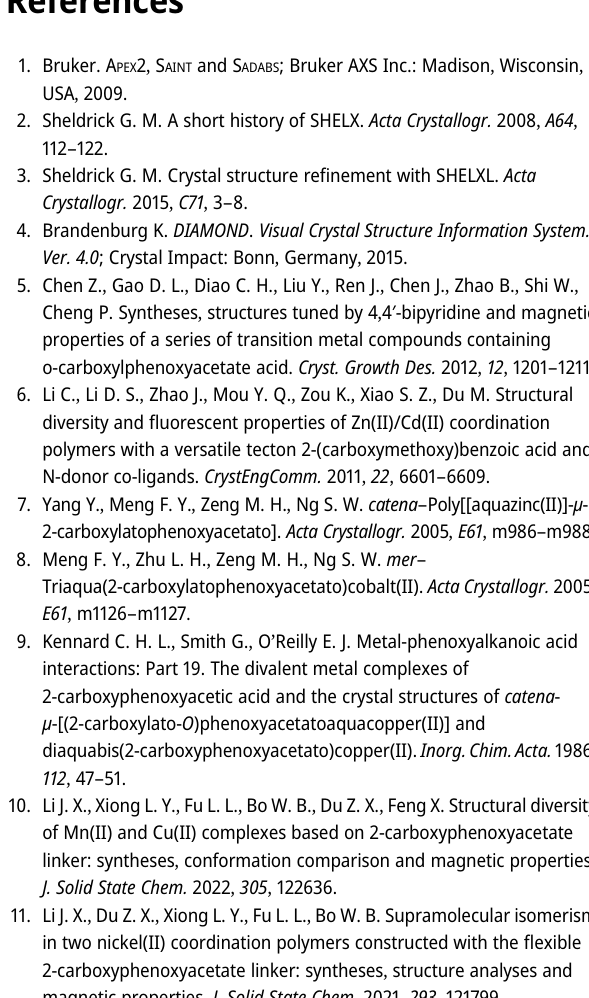
nated water O atoms [O(6), O(7) and O(8)] and four carboxy O atoms [O(1), O(2), O(4) and O(5)] link the complexes into a hydrogen bonded network.